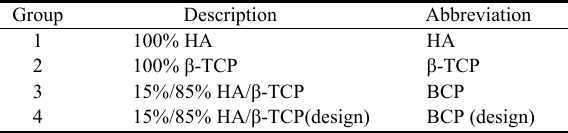
Summary of the four primary experimental scaffold groups used for the in vitro dissolution evaluation of Ca and PO 4 release over a set amount of